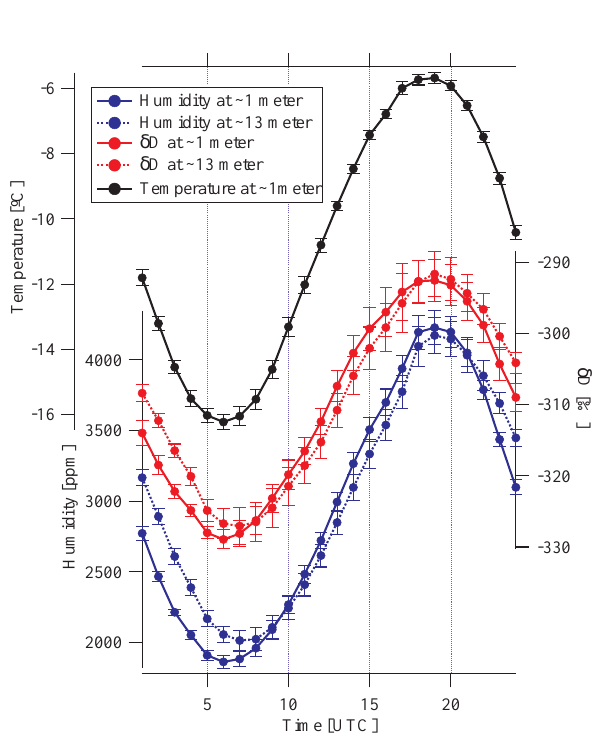
Fig. 4. The mean diurnal cycle on days with clear sky and calm weather. Stacked based on diurnal cycles between days ∼ 180 and ∼ 190. Error bars indicate the standard deviation on the mean. Solid lines represent measurements at ∼ 1m above snow surface. Dashed lines represent measurements at ∼ 13m above snow surface. Blue lines represent humidity, red lines represent δ D, and black line rep- resents